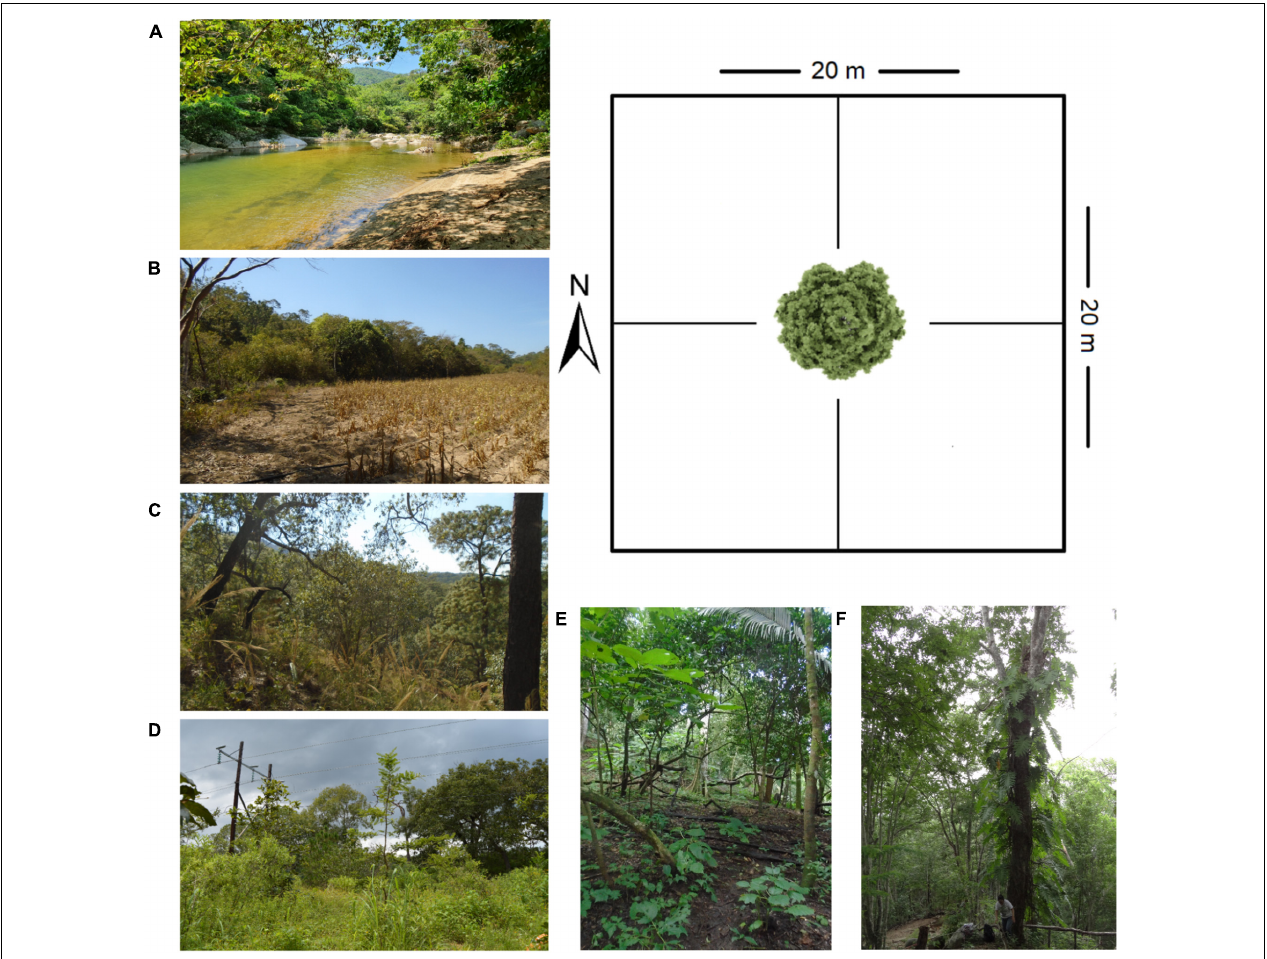
FIGURE 2 | Diagram of the plot and view of the sampling sites. (A) NGF = natural gallery forest, (B) DGF = disturbed gallery forest, (C) NOF = natural oak forest, (D) DOF = disturbed oak forest, (E) NTSF = natural tropical sub-deciduous forest, (F) DTSF = disturbed tropical sub-deciduous